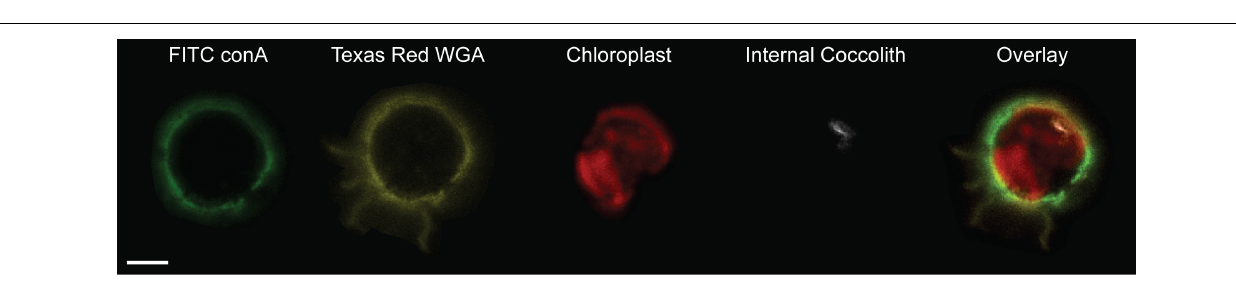
FIGURE 5 | Differential localization of ConA and WGA lectin stains in S. apsteinii. Confocal sections of a decalcified S. apsteinii cell stained simultaneously with FITC-ConA and Texas Red-WGA. Both lectins localize around the cell body but Texas Red-WGA staining is additionally found on the residual polysaccharides from the dissolved lopadoliths (yellow). Chlorophyll autfluorescence (red) and reflectance of the internal coccolith (white) is also shown. Scale bar represents 5 µ